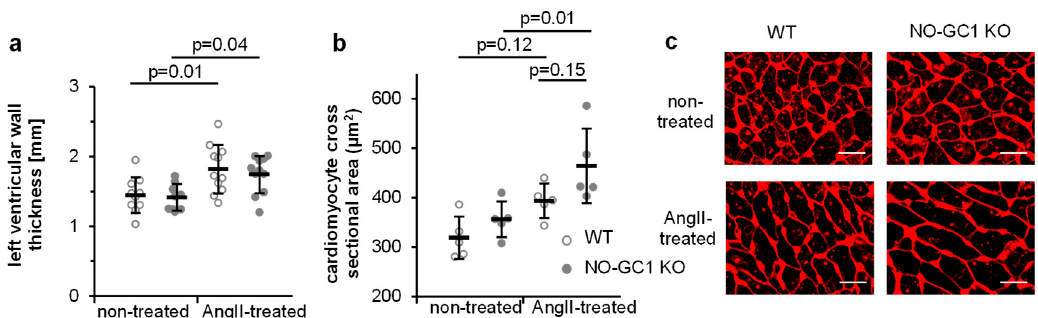
Figure 3. AngII induced increase of left ventricular wall thickness and cardiomyocyte cross sectional area. ( a ) Left ventricular wall thickness was measured in hearts of non-treated and AngII-treated WT and NO-GC1 KO mice. Individual values (per animal) are shown together with means ± SD. ( b ) Cardiomyocyte cross sectional areas of WGA-stained heart slices ( c ) were quantified. Individual values (per animal) are shown together with means ± SD. ( c ) Shown are representative WGA-stained heart sections. Scale bar, 20 µm.